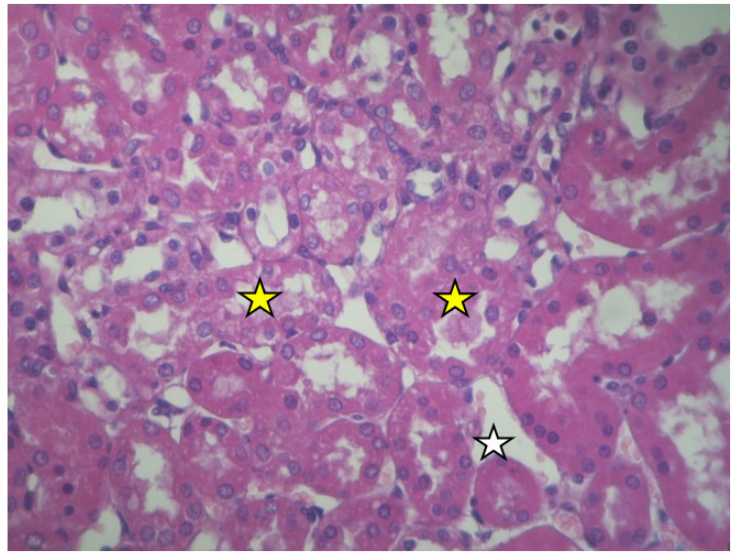
Figure 4. Cortex of resuscitated swine stained with HE. Destroyed tubular epithelium and amorphous material fills the tubular lumen (yellow stars). Expanded capillary (white star), ×160.